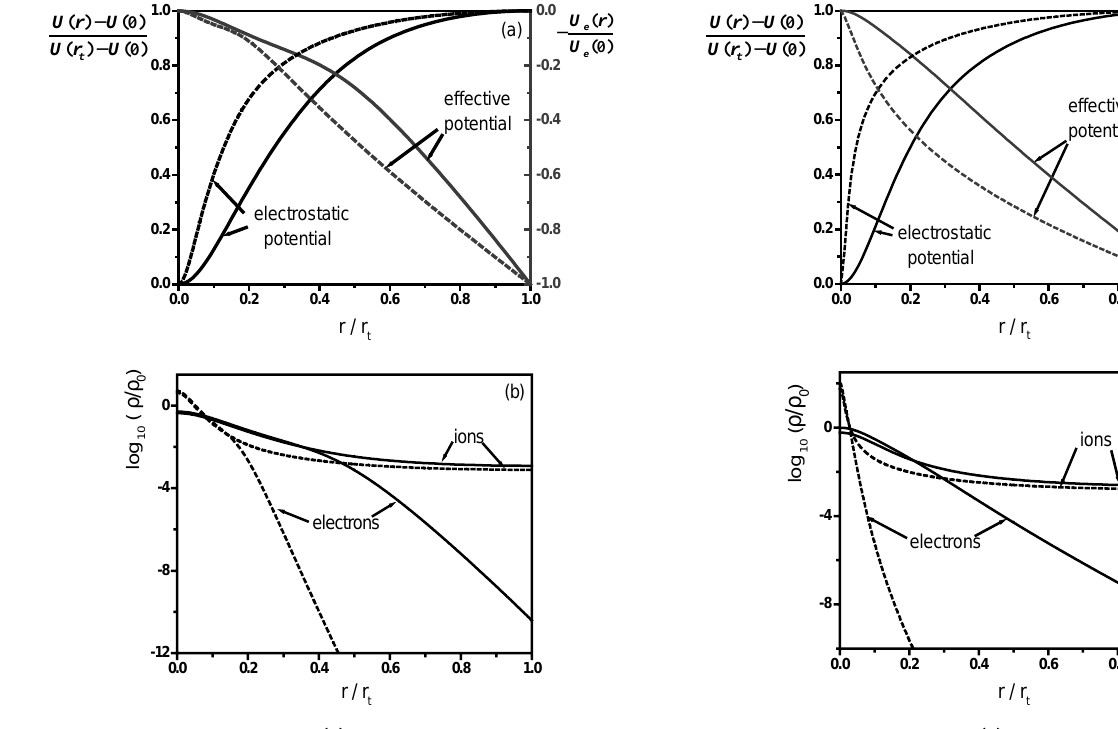
FIG. 1. Radial functions for (a) electrostatic and effective po- tentials and (b) space charge of electrons and ions, calculated for a 50 keV electron beam and neutralizing ions with a tem- perature related to m i (cid:1) 11.5 . Full lines correspond to hotter ( m e (cid:1) 114 ) electrons and dashed lines to colder ( m e (cid:1) 201 ) electrons.